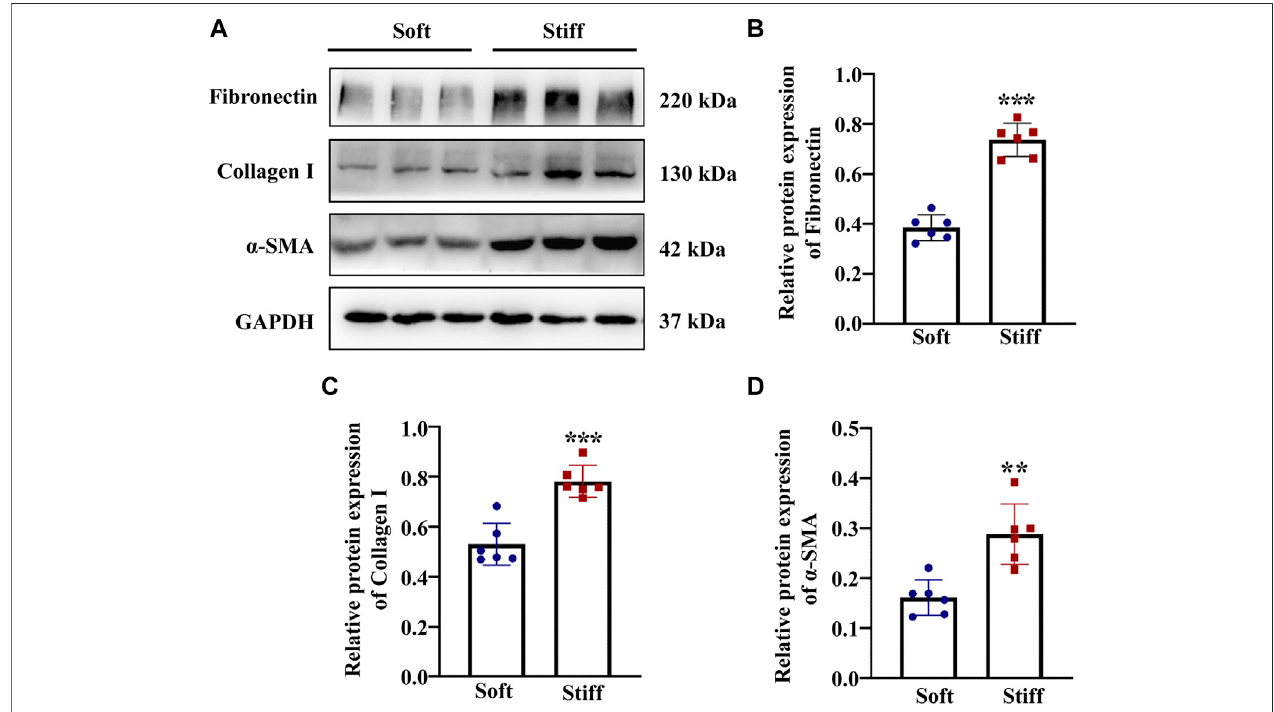
FIGURE1| ECMstiffnessactivatesMCs.MCswereculturedonhydrogelsofdifferentstiffness(2 kPaand50 kPa)for48 h. (A) RepresentativeWesternblotbands show expression levels of the myo fi broblast marker α -SMA and ECM-associated proteins include of Collagen I and Fibronectin in cells cultured on soft and stiff hydrogels. The bar graphs show the results of semi-quantitative measurements of Fibronectin (B) , Collagen I (C) and α -SMA (D). ( n (cid:1) 6; * p < 0.05, ** p < 0.01, *** p < 0.001).